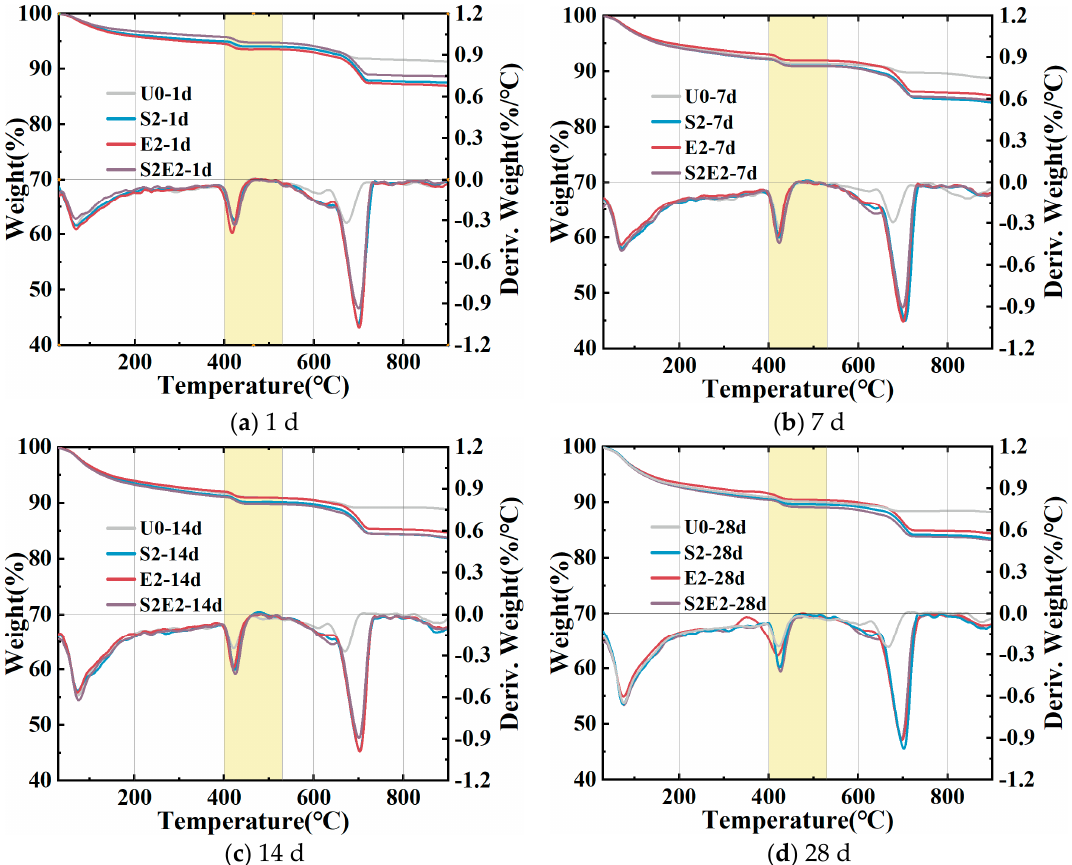
Figure 9. TG curves of U0, S2, E2, and S2E2. ( a ) 1 d; ( b ) 7 d; ( c ) 14 d; ( d ) 28 d. Table 7. Calcium hydroxide amount in the UHPC matrix (wt%).